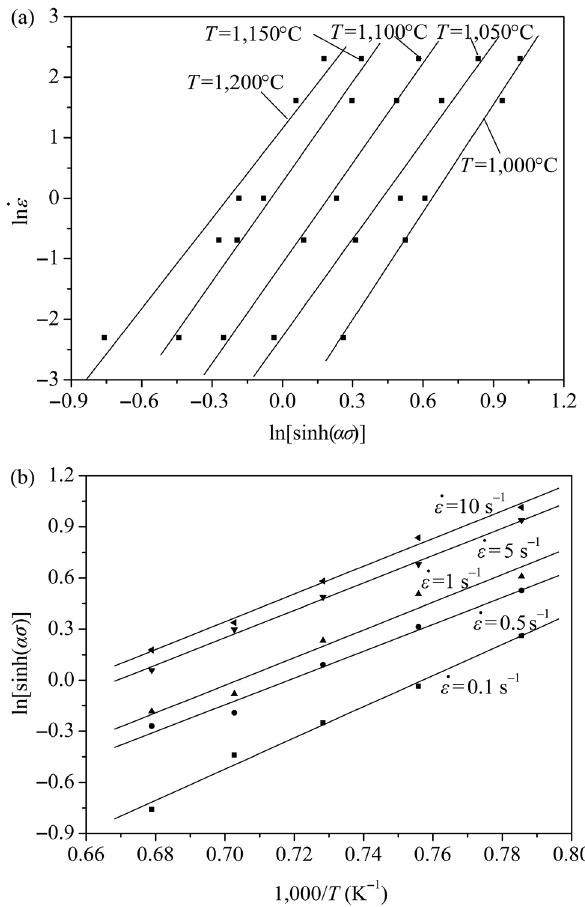
Figure 8: Relationships (a) between ln _ ε and ln[sinh( ασ )] and (b) between ln[sinh( ασ )] and 1,000/ T.